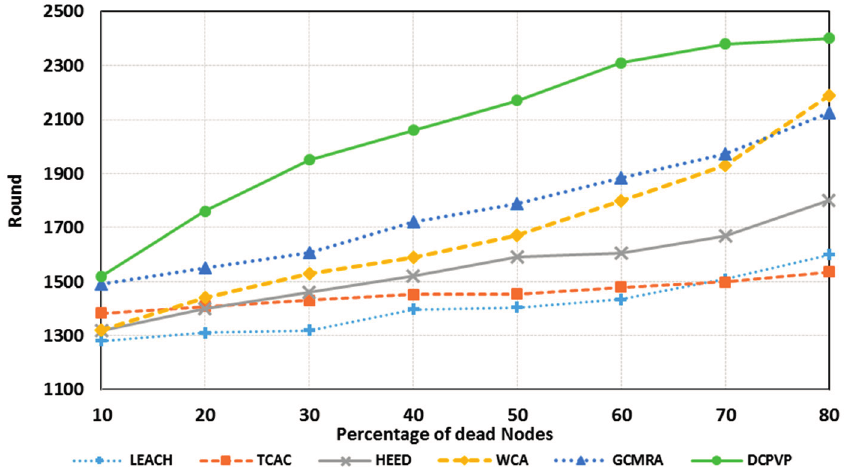
Figure 15. The percentage of dead nodes in random distribution for 150